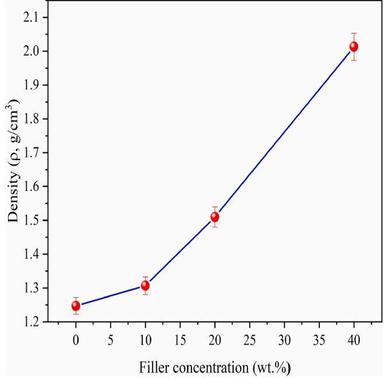
Composite density variation vs nanofiller ratio.